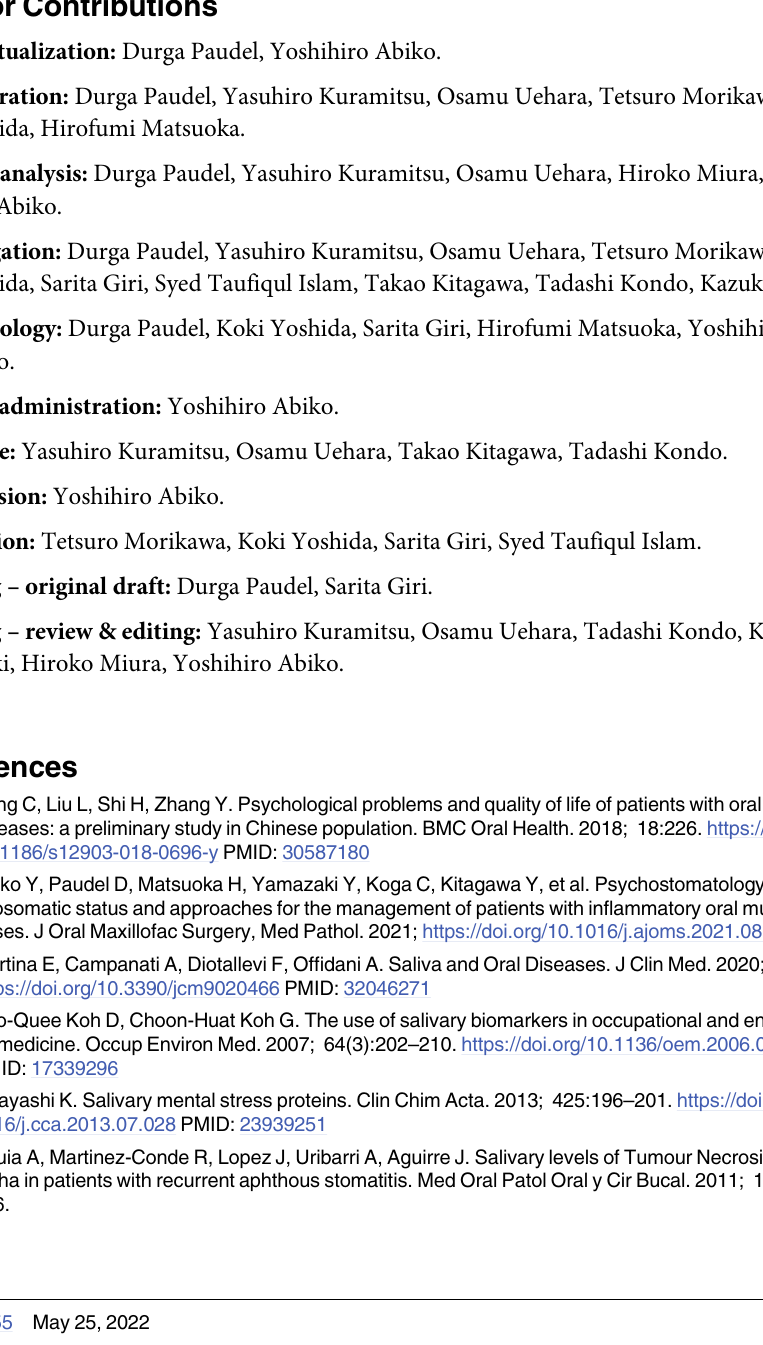
S4 Fig. The gel images used for quantification of protein spots is deposited in figshare and is available as https://doi.org/10.6084/m9.figshare.19333859.v1. (PDF) S1 Raw images. Blot images of western blot. The blot images are deposited in figshare and is available as https://doi.org/10.6084/m9.figshare.19387415.v1.